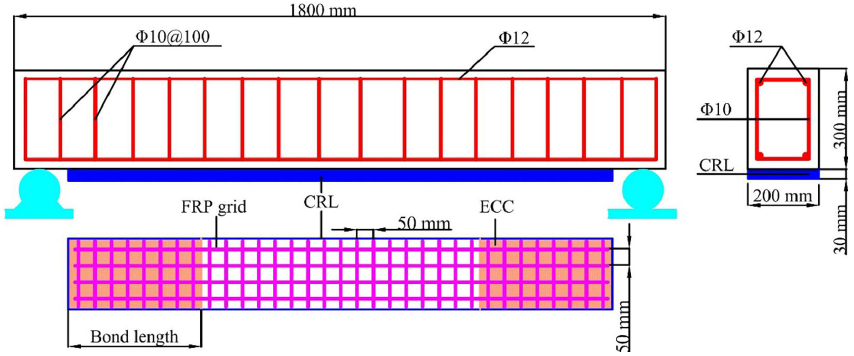
Figure 1. Structural dimensions of the experimental RC